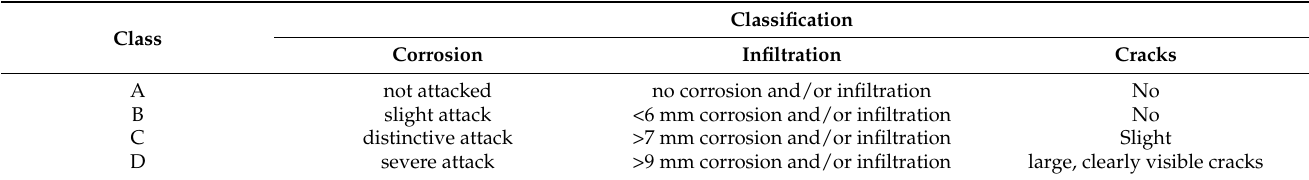
Table 4. Alkali test classification after internal regulation of P-D Refractories CZ [26].